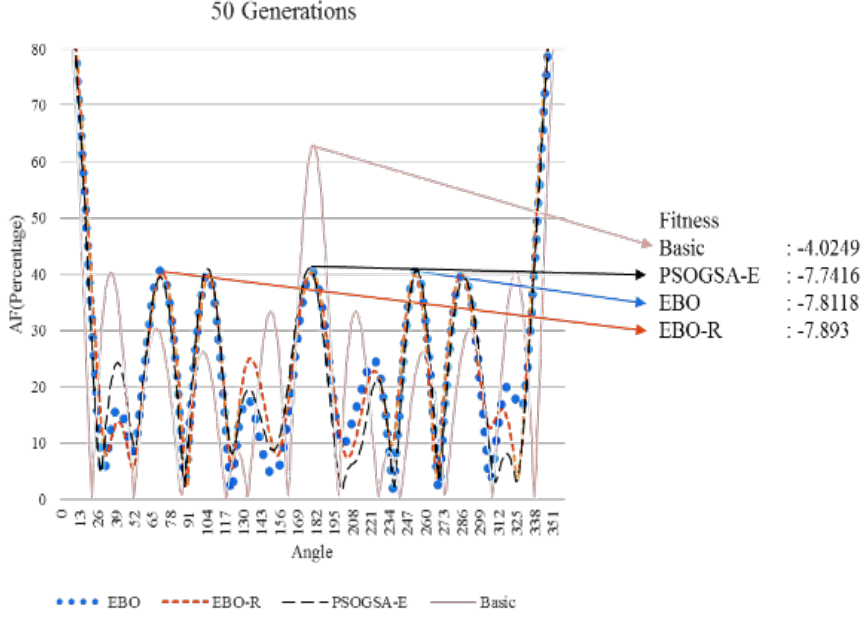
Figure 10. Beam patterns of different algorithms (50 generations).